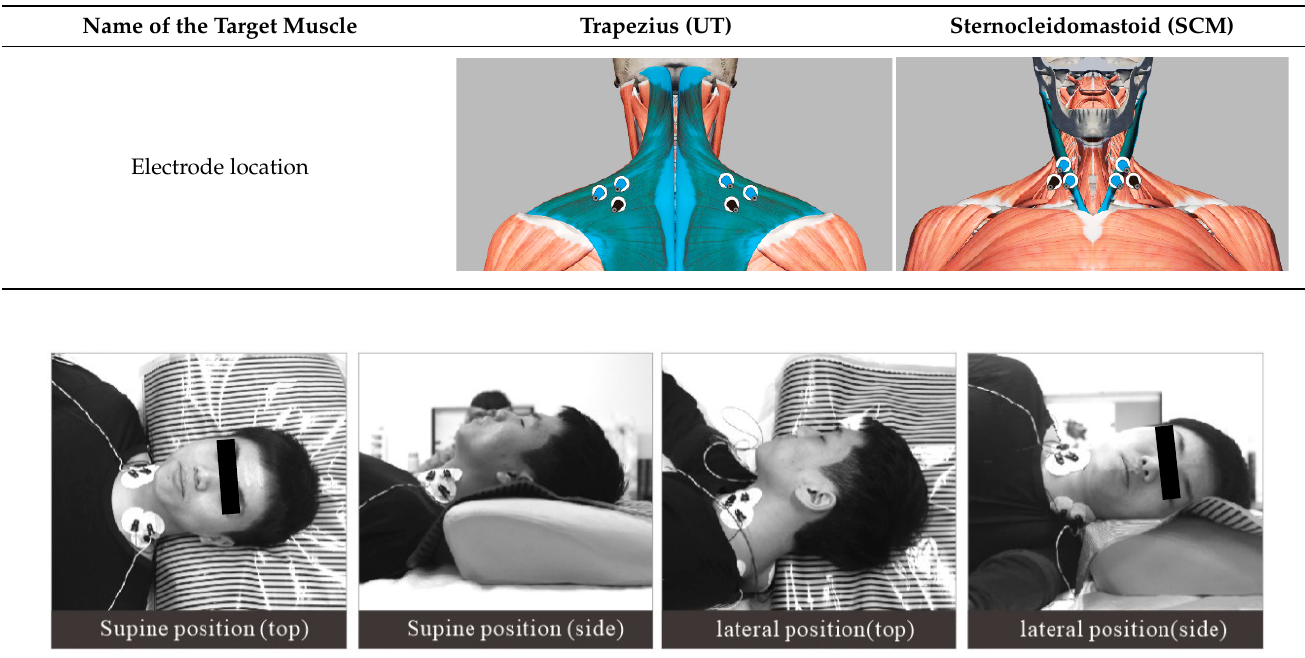
Figure 1. Pressure distribution experiment under the monitoring of EMG signal.